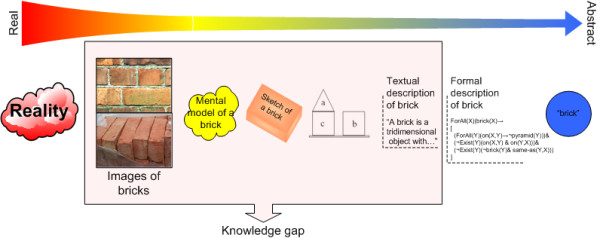
Representations of "brick" on the knowledge spectrum. Such representations range from rich (e.g., images, mental models) to less complex (sketches and diagrams) and to symbolic descriptions (textual, formal and conceptual).